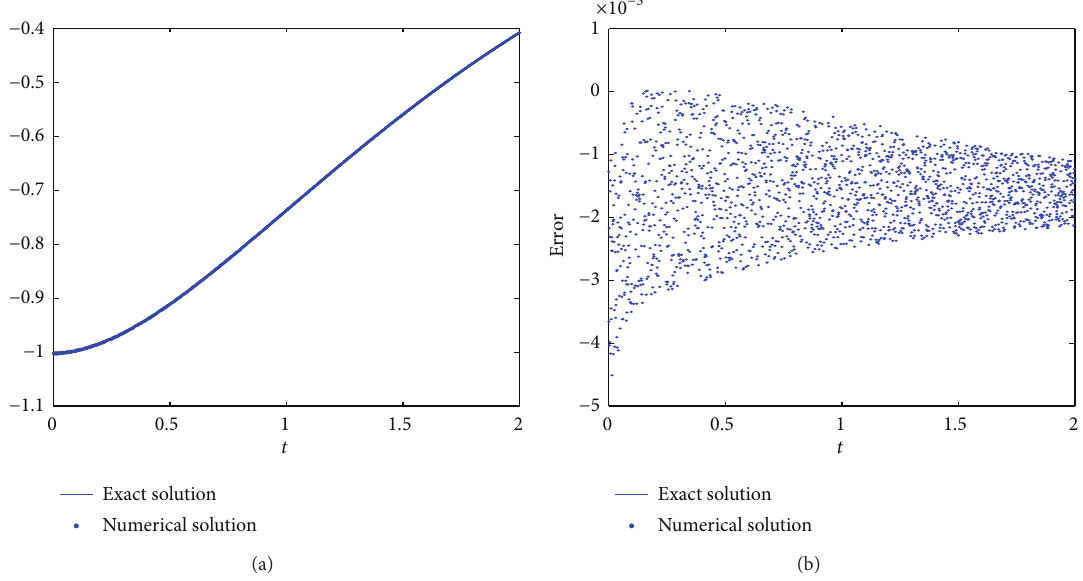
̂𝑓(𝑡) ̂𝑓(𝑡) (a), the error 𝑓(𝑡) − (b) with 𝑞 = 0.001 .